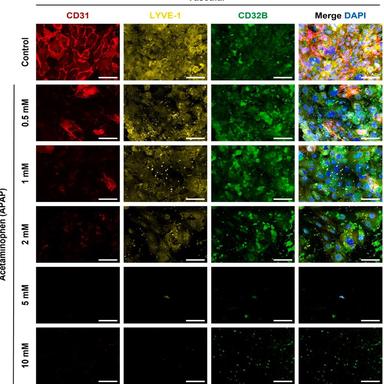
Morphological analysis of vascular cell layers in the Dynamic42 3D model. Representative immunofluorescence images of upcyte® LSECs (donor 462) stained for CD31 (red), LYVE-1 (yellow), CD32D (green), nuclei (DAPI, blue) after treatment with control (10% PBS) or 0.5, 1, 2, 5 and 10 mM APAP for 7 days. Bar - 100 µm.